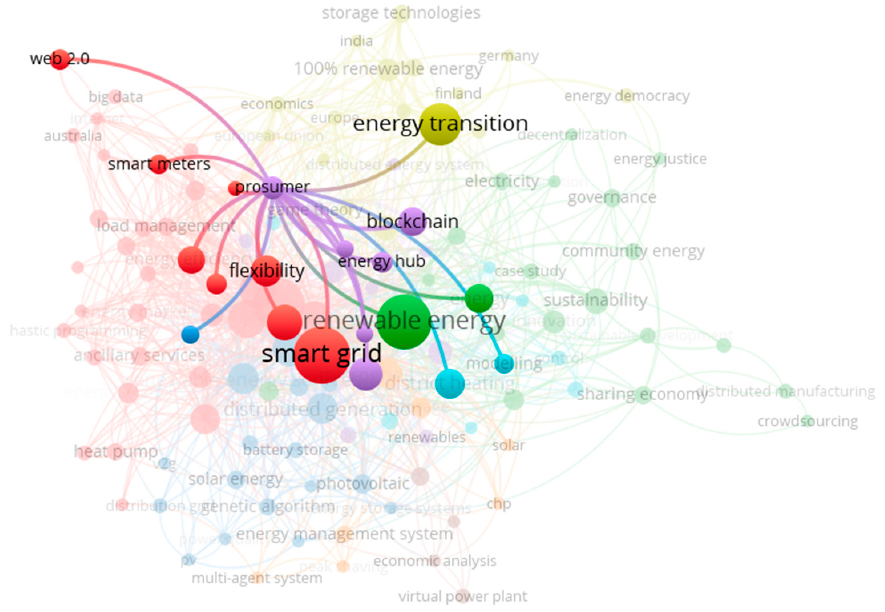
Figure 17. Highlighting the connections around ‘prosumer’.